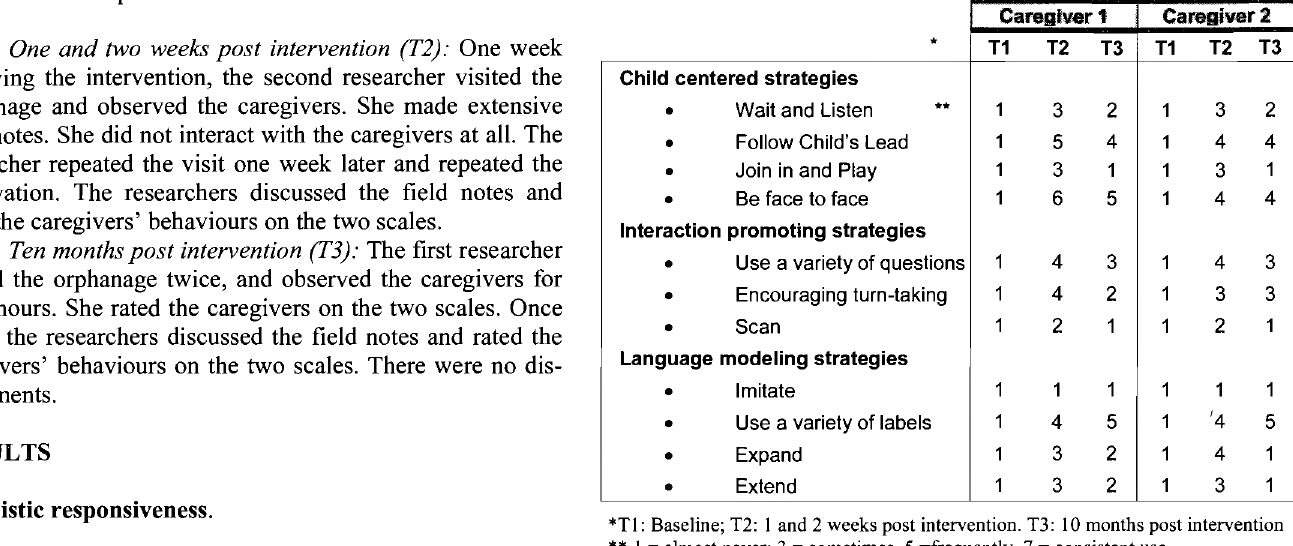
Table 4: Teacher Interaction and Language Rating Scale (Girolametto et al., 2000) baseline and outcome ratings